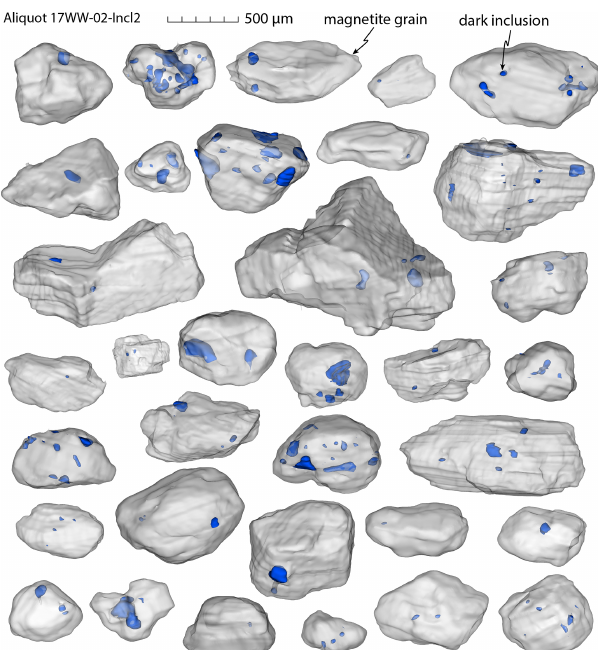
Figure 6. Segmented volume renderings of magnetite grains with dark inclusions (dark blue) constructed from microCT data. These are all of the grains from aliquot 17WW-02-Incl2 (only dark inclu- sions); for helium data see Table 3.